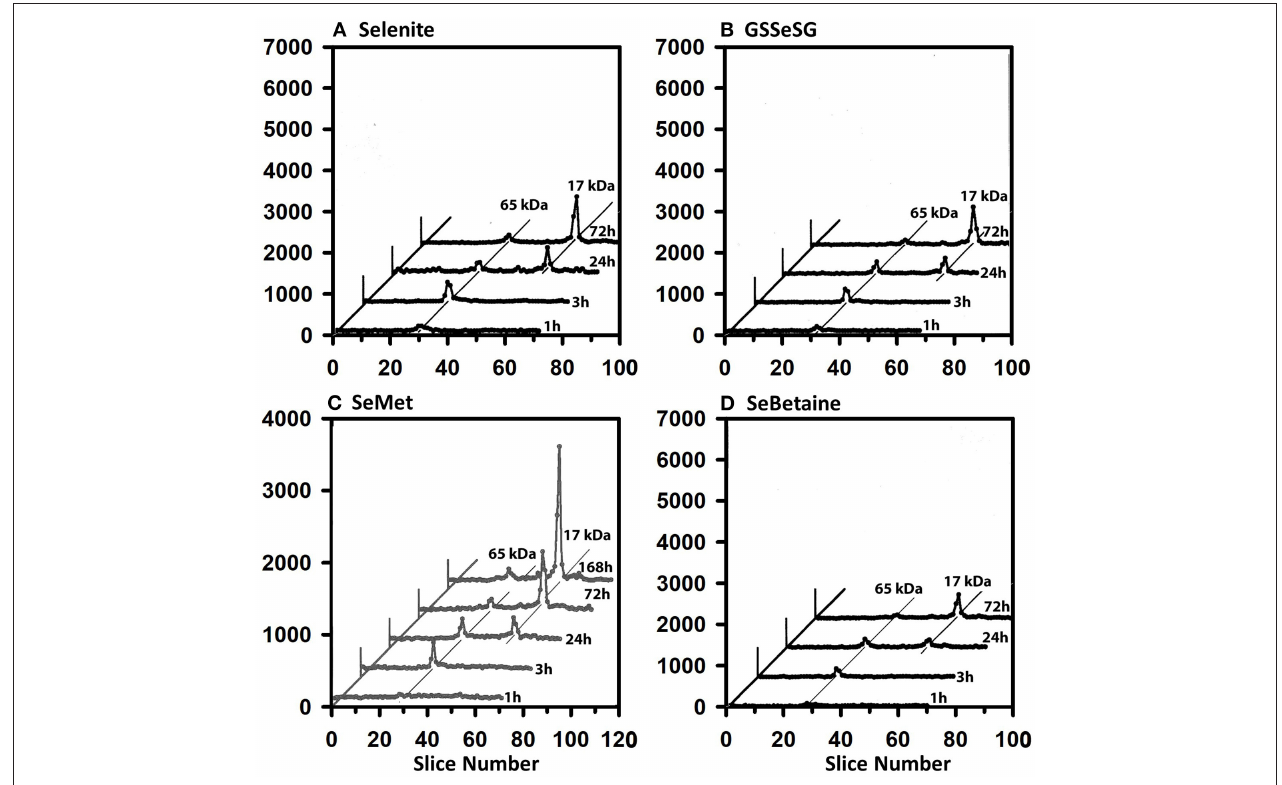
FIGURE 6 | Incorporation of 75 Se into testes supernatant proteins from Selenite (A) , GSSeSG (B) , SeMet (C) , and SeBetaine (D) . Rats were treated as described for Figure 3 . Testes supernatants were prepared and analyzed by SDS/PAGE, as described for Figure 5 ( n = 17 total rats). GPX4 is 17 kDa, and the 65 kDa species are likely to the isoenzymes of